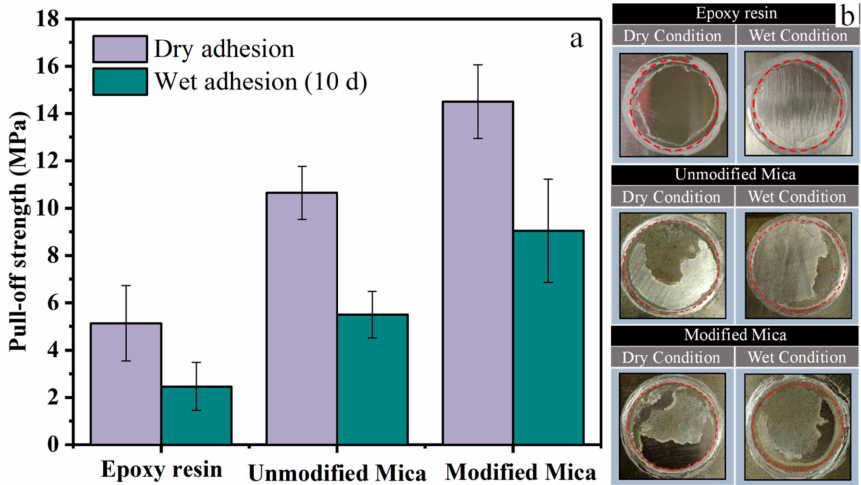
Figure 10. ( a ) Pull-off test results and ( b ) detaching status